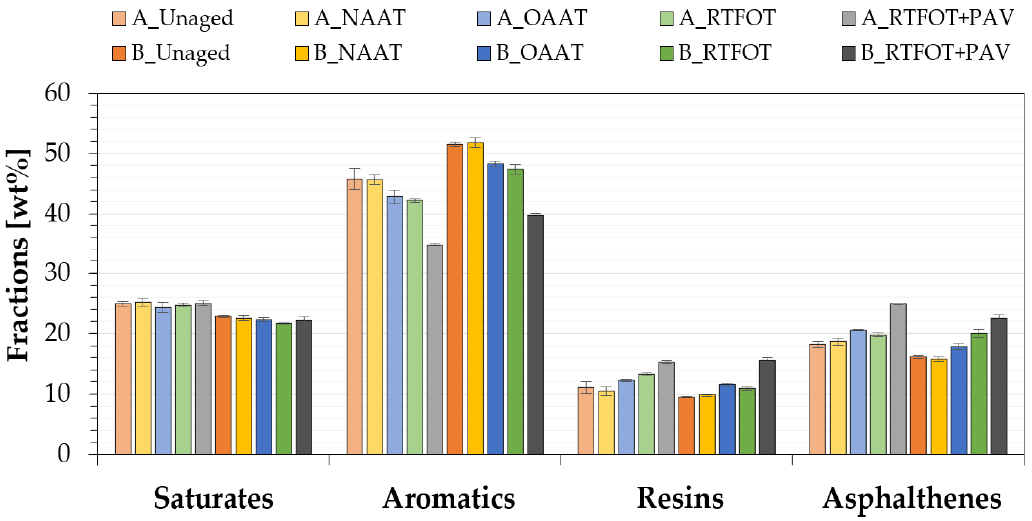
Figure 10. SARA fractions percentages at different aging states.